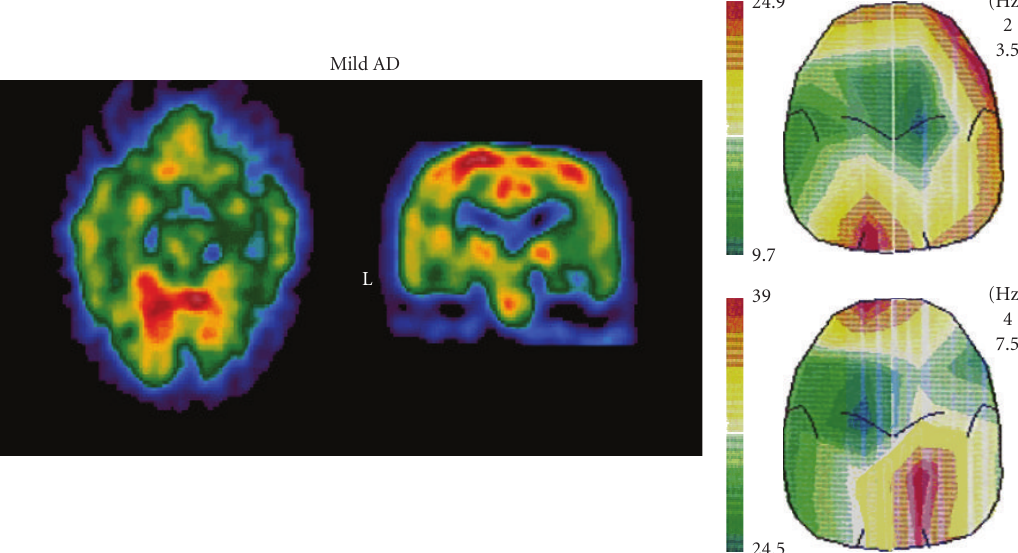
Figure 3: Sample of SPECT neuroimaging (Tc-99 HMPAO) and EEG brain mapping in a mild AD patient. Topographic scalp distribution of the EEG power on the 2.0 to 3.5Hz frequency band (top right) and 4.0 to 7.5 Hz frequency band (bottom right) is shown. For more details, see text.